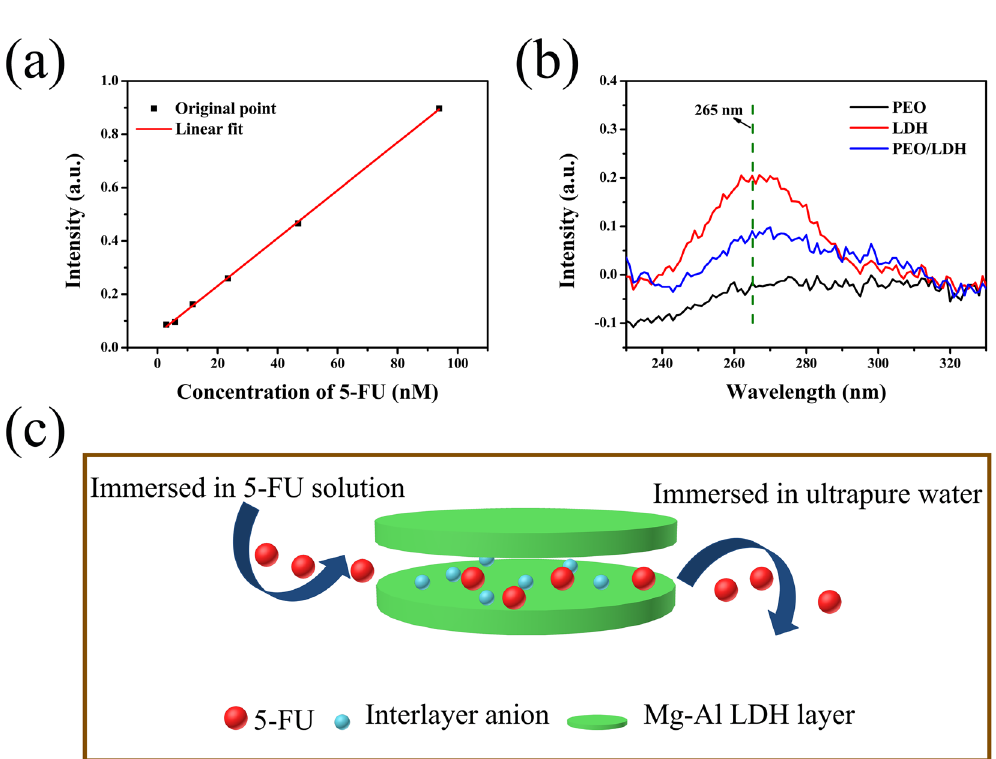
Figure 11. The standard curve of 5-FU ( a ), the ultraviolet absorption spectrum of the solution after releasing 5-FU, and the process of loading-releasing 5-FU ( c